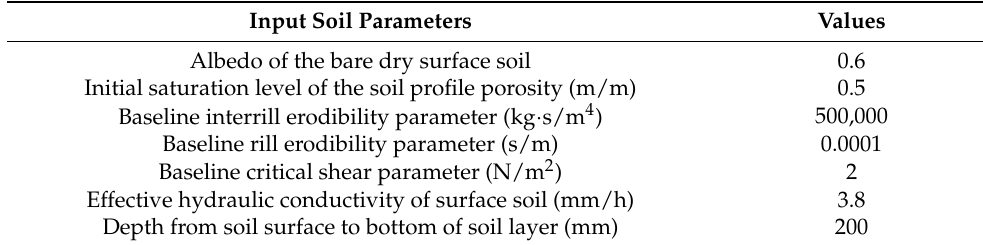
Table 2. Soil parameters for road surface erosion modelling with WEPP. Input Soil Parameters Values Albedo of the bare dry surface